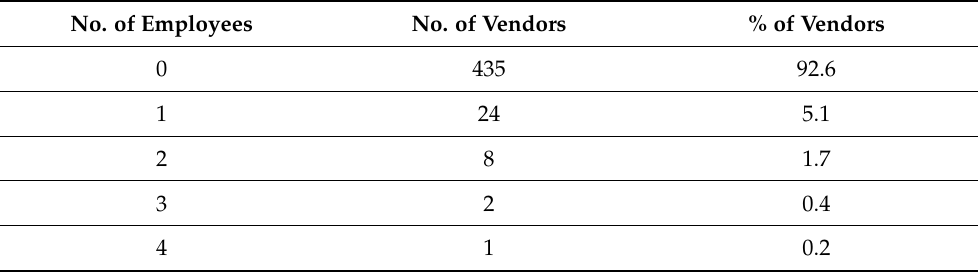
Table 11. Employment creation by food